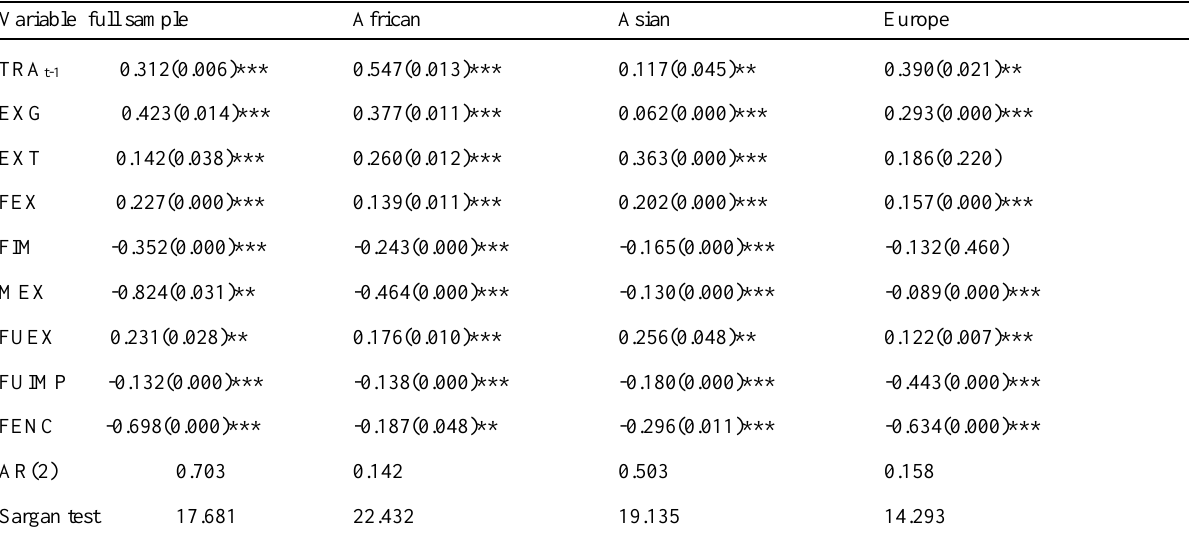
Table 3: GMM Results (Dependent Variable: